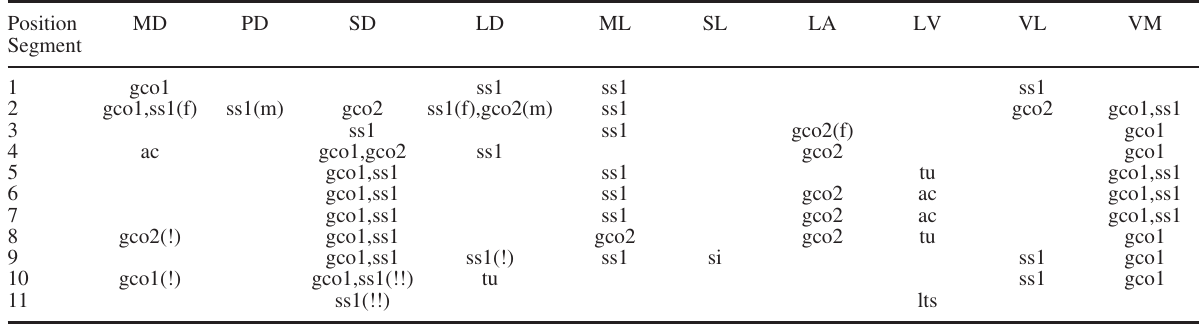
on segment 10. Males with two lateral penile spines, females without lateral terminal accessory spines. Pu- tative type II glandular cell outlets with conspicuous tuft of cuticular extensions present in various positions. Segment 9 with large, elongated sieve plate, located in a sublateral position, anterior to distinct pore. Etymology. The species name “ rex ” is from Latin, meaning “king”, and refers to the species’ distinct and prominent appearance in light microscopy, as well as its considerable trunk length, making it the largest of all known species of Echinoderes . Description. The adult specimen consists of a head, a neck and eleven trunk segments (Figs 1A, 2A,3). Table 2. – Summary of nature and location of sensory spots, glandular cell outlets and spines arranged by series in Echinoderes rex n. sp. from the Korea Strait. Abbreviations: LA: lateral accessory; LD: laterodorsal; LV: lateroventral; MD: middorsal; ML: midlateral; PD: paradorsal; SD: subdorsal; SL: sublateral; VL: ventrolateral; VM: ventromedial; ac, acicular spine; f, female condition of sexual dimorphic character; gco1, glandular cell outlet type I; gco2, modified glandular cell outlet type II; lts, lateral terminal spine; m, male condition of sexual dimorphic character; si, sieve plate; ss1, sensory spot type 1 (for some sensory spots it was not possible to determine their types); tu, tubule; (!) only observed in one individual; (!!) observed in some, but not all of the examined animals. Position MD PD SD LD